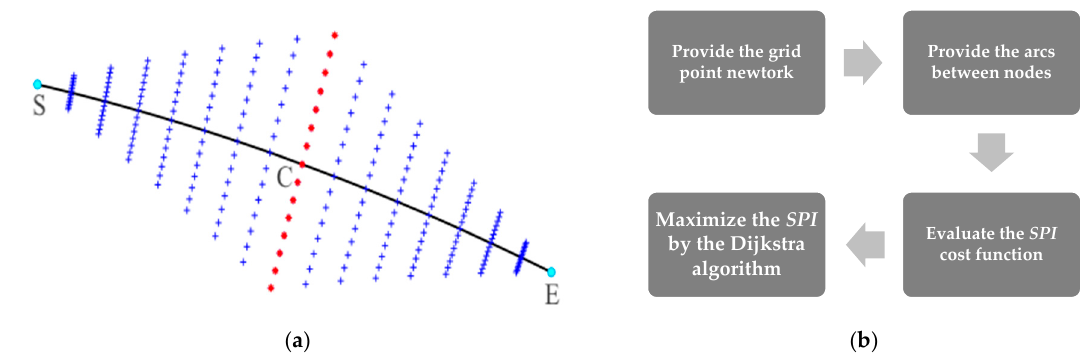
Figure 1. Adaptive weather routing algorithm: ( a ) Grid point network, ( b ) flow chart. SPI : Seakeeping Performance Index.